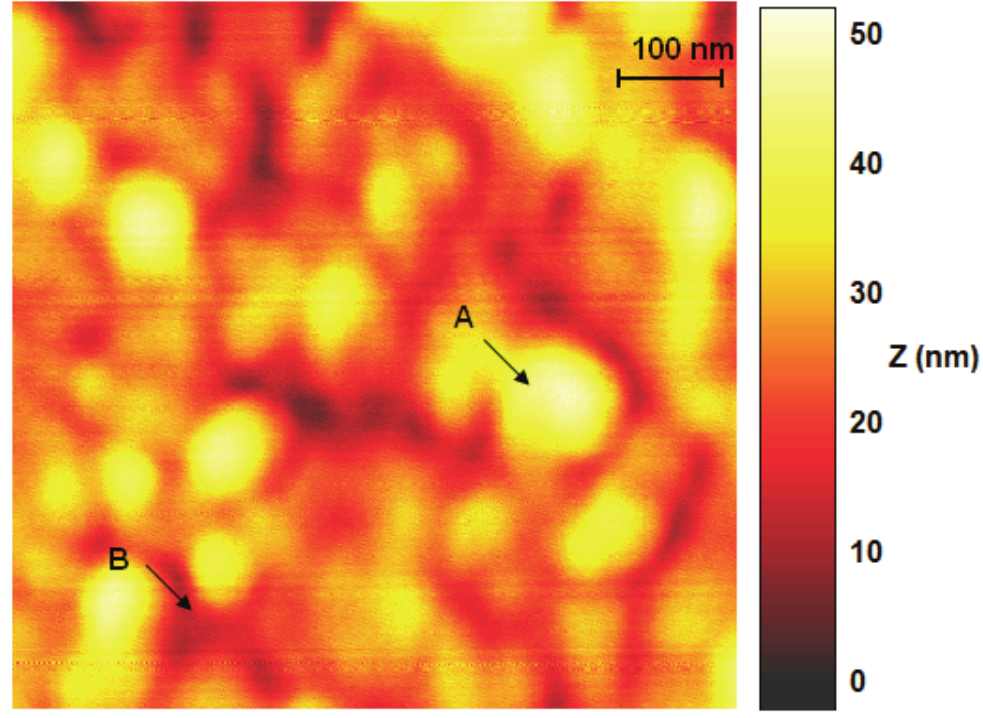
Figure 2. AFM image of gold nanorods layer formed on 1,6-HDT modified gold plate. A—protruding nanorod, B—cracks between